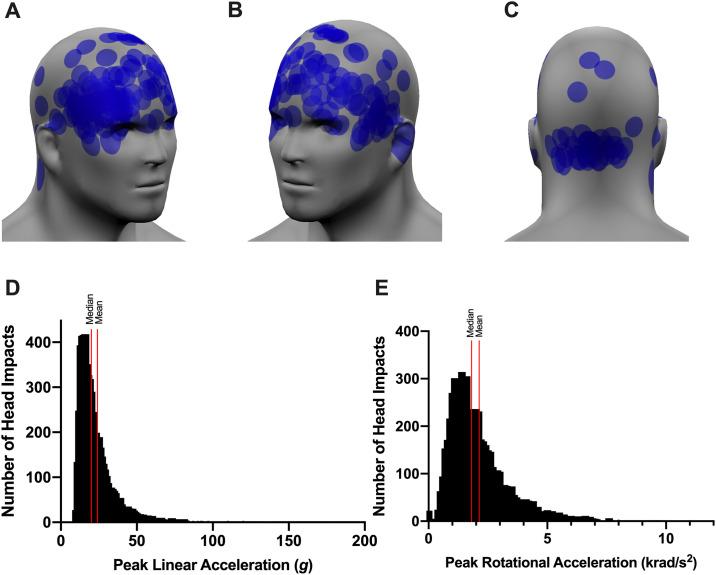
Head impact distribution in 24 high school football players in a single season.A representative data from a defensive lineman demonstrates the estimated locations of hits based on the data from the Vector mouthguard (A, front right; B, front left; C, back). Histogram of distribution of peak linear acceleration (D) and peak rotational acceleration (E) for all hits occurred during 5 levels-of-contact.